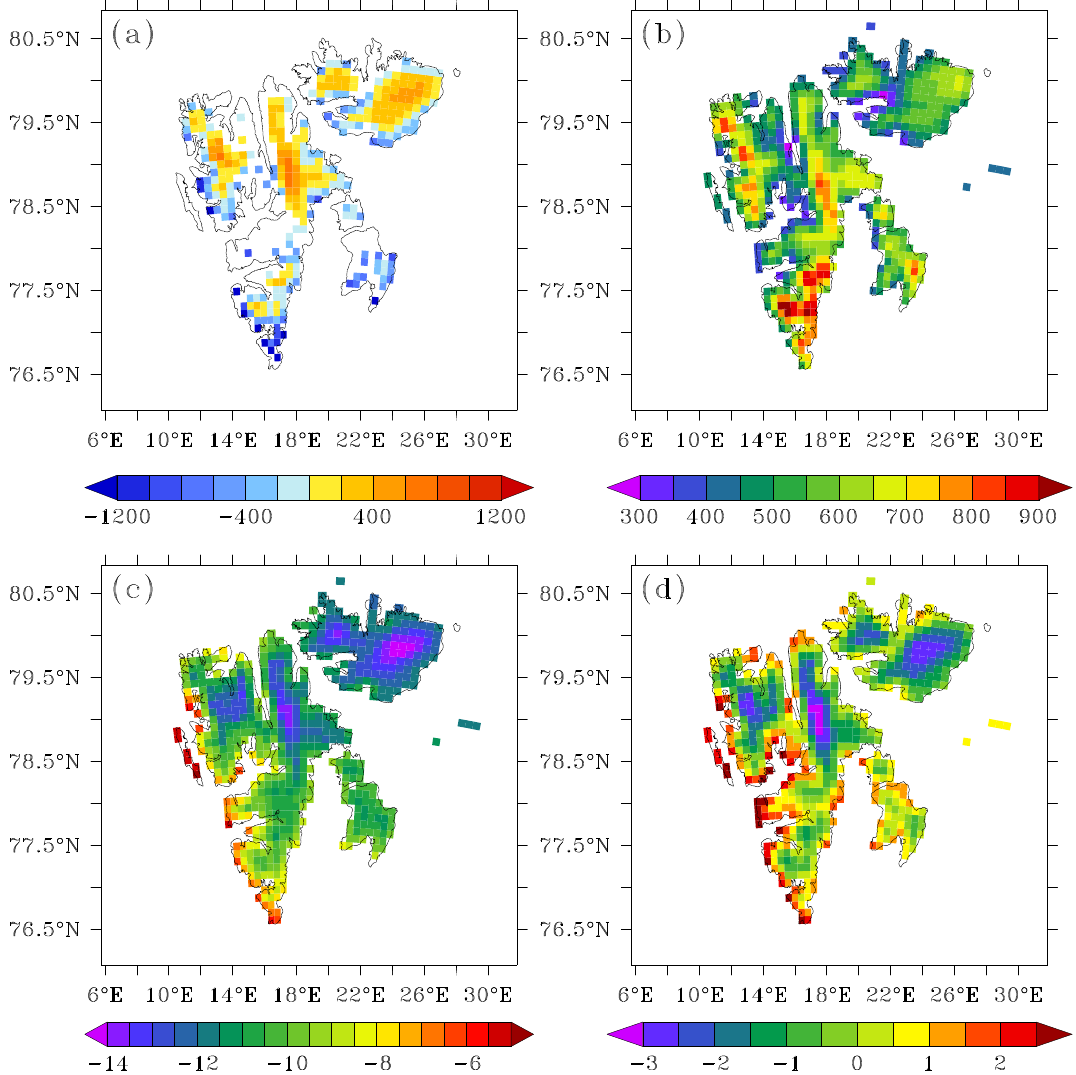
Figure 7. (a) Mean annual SMB (mmw . e . yr − 1 ) averaged over 1979–2013. (b) Same as (a) for the annual precipitation (mmw . e . yr − 1 ). (c) Same as (a) for the mean annual near-surface temperature (TAS) ( ◦ C). (d) Same as (a) for the mean summer near-surface temperature (TAS JJA ) ( ◦